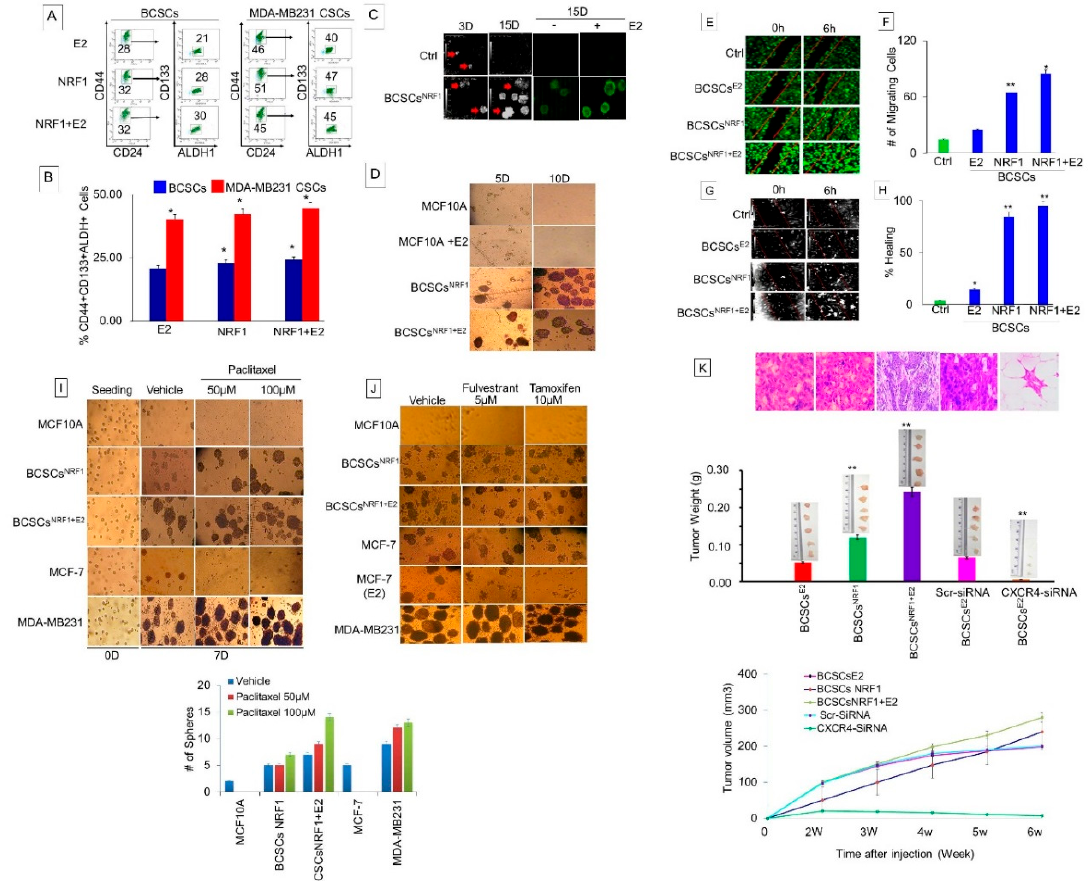
Figure 4. Identification of the mesenchymal-like “migrating and metastasis initiating” breast cancer stem cell phenotype clone. ( A ) NRF1+E2 CD24 − CD44+ BCSCs were further flow sorted for the isolation of the CD24 − CD44+CD49f+ALDH+CXCR4+CD133+. ( B ) Graph showing NRF1+E2-transformed MCF10A cells displaying CD44+CD49f+ALDH+CXCR4+NRF1+ BCSCs subtype and the most